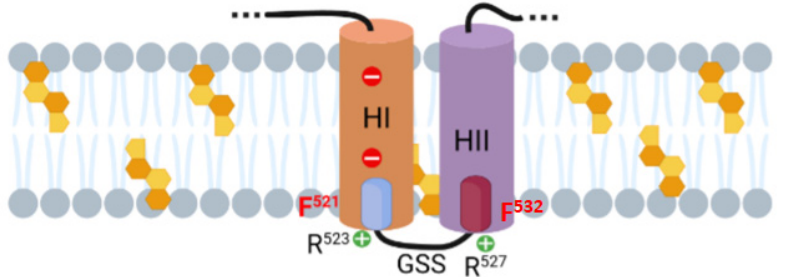
Figure 10. Schematic representation of the proposed membrane topology for HI and HII helices of the pore-forming domain of ACT. Proposed topology for the HI and HII helices as predicted by the algorithm Philius (https://topcons.cbr.su.se/, accessed on 20 February 2021); the two cholesterol recognition motifs identified in this study, CARC 532 and CRAC 521 motifs, are represented by blue and purple cylinders, respectively, and the central aromatic residue of each site (F521 and F532) is high- lighted in red. Cholesterol molecules are represented by orange-coloured penta-hexagonal figures. More details are explained in the Discussion section. Original picture created with